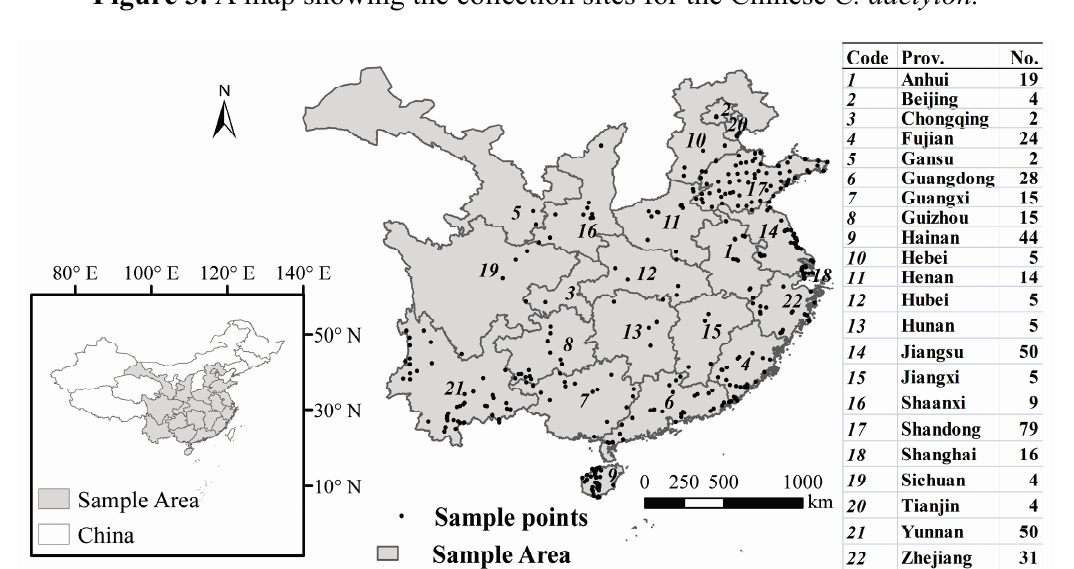
Figure 3. A map showing the collection sites for the Chinese C.